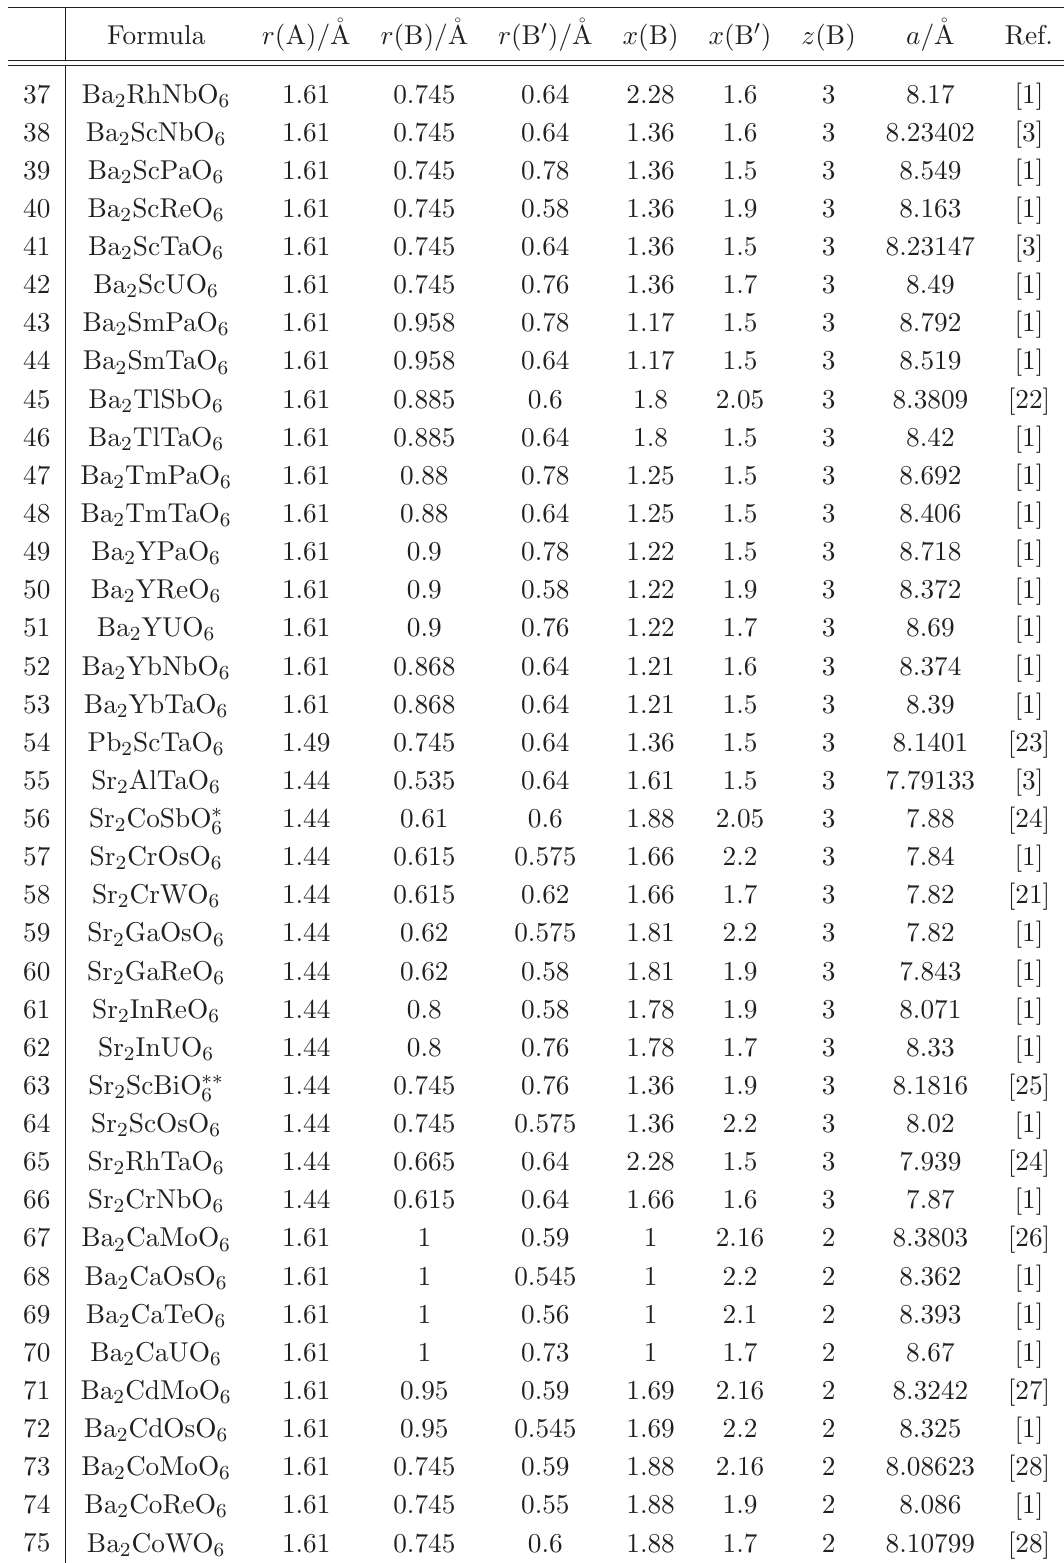
Table 1 (continue) Input data in the analysis: radii of the constituents ( r ), electronegativity of the B-cations ( x ), the oxidation state of B-cation ( z ) and lattice parameter ( a